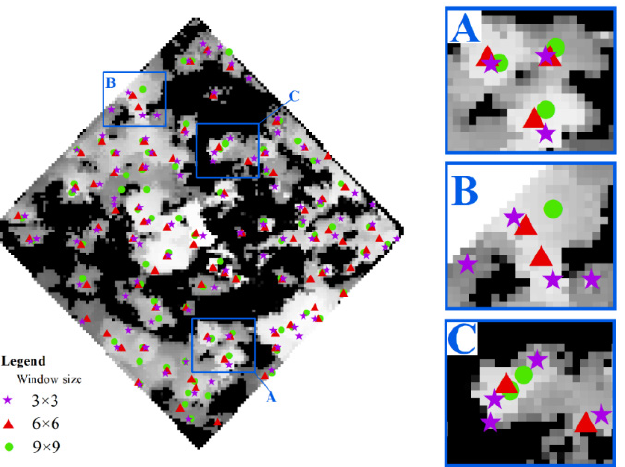
Figure 7. The sensitivity analysis of the LM in plot 8. ( A ) is accurate detected, ( B , C ) are the over- segmentation.